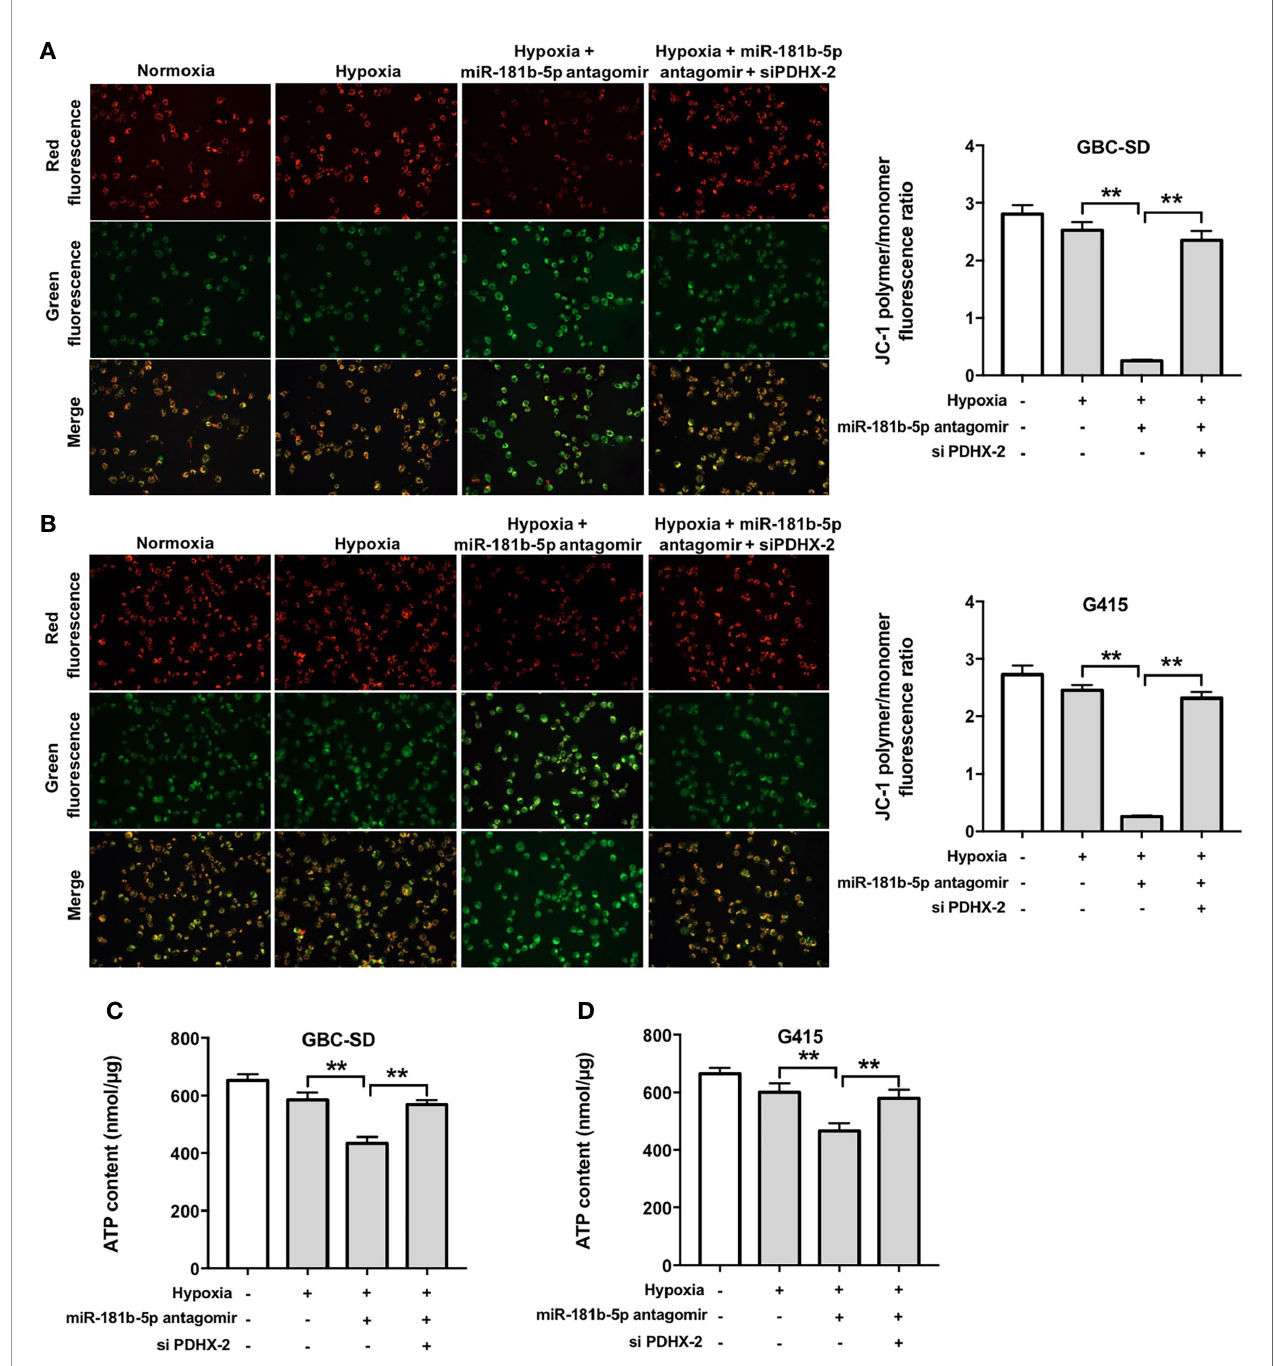
FIGURE 7 | Downregulation of miR-181b-5p impairs the mitochondrial function in GBC cells under hypoxia by upregulating PDHX. (A, B) JC-1 staining assay was used to study the change in MMP in GBC cells. (C, D) ATP level in GBC cells were detected. **P <